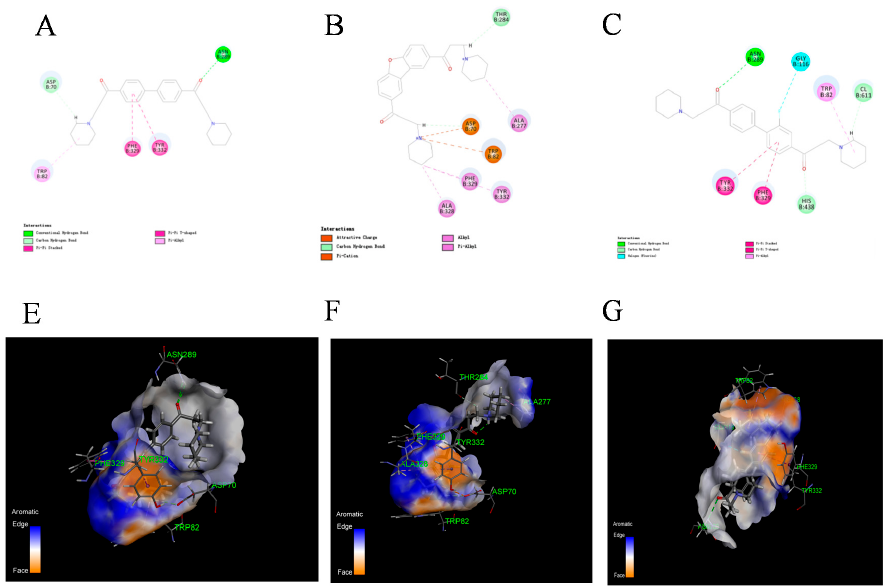
Figure 5. Visualization of the non-bond interactions between the protein and ligands. The figures of A and D showed the interaction between BuChE and DL0410. Biphenyl and piperidine rings of DL0410 interacted TRP332, PHE329 and TRP82 via π - π stacking or π -alkyl interaction. The carbonyl group could form hydrogen bonds via interacting ASN289. Figure B and E suggested compound 6-1 had the strongest interaction with BuChE. The piperidine of compound 6-1 had a stronger electrostatic attraction with APS70 and TRP82, and π -Alkyl interaction with ALA328, PHE329, and TYR332. From Figure C and F , we observed that compound 7-6 also had stronger interaction with BuChE than that of DL0410. There existed more hydrogen bonds for compound 7-6 , and a highly electronegative fluorine atom caused its strong interaction with